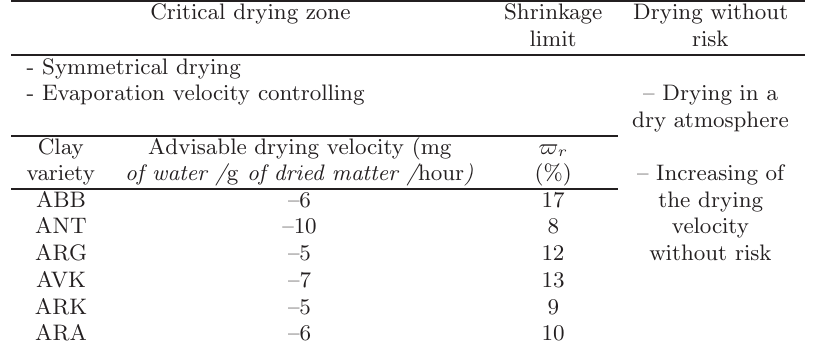
Table 2. Drying parameters and controlling advisable for the six clay varieties matrixes